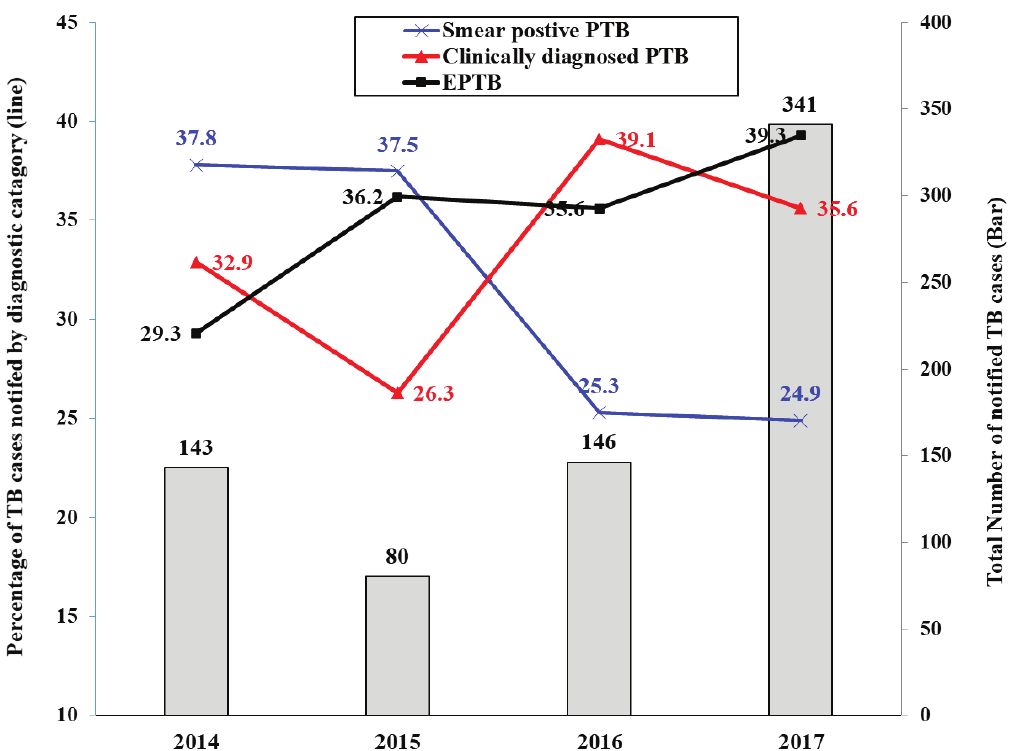
Figure 1 : Trends of notified TB cases (bar) by diagnostic category (line) in Al Kashafa, Wadsherify, and Shagarab refugee camps, Sudan,